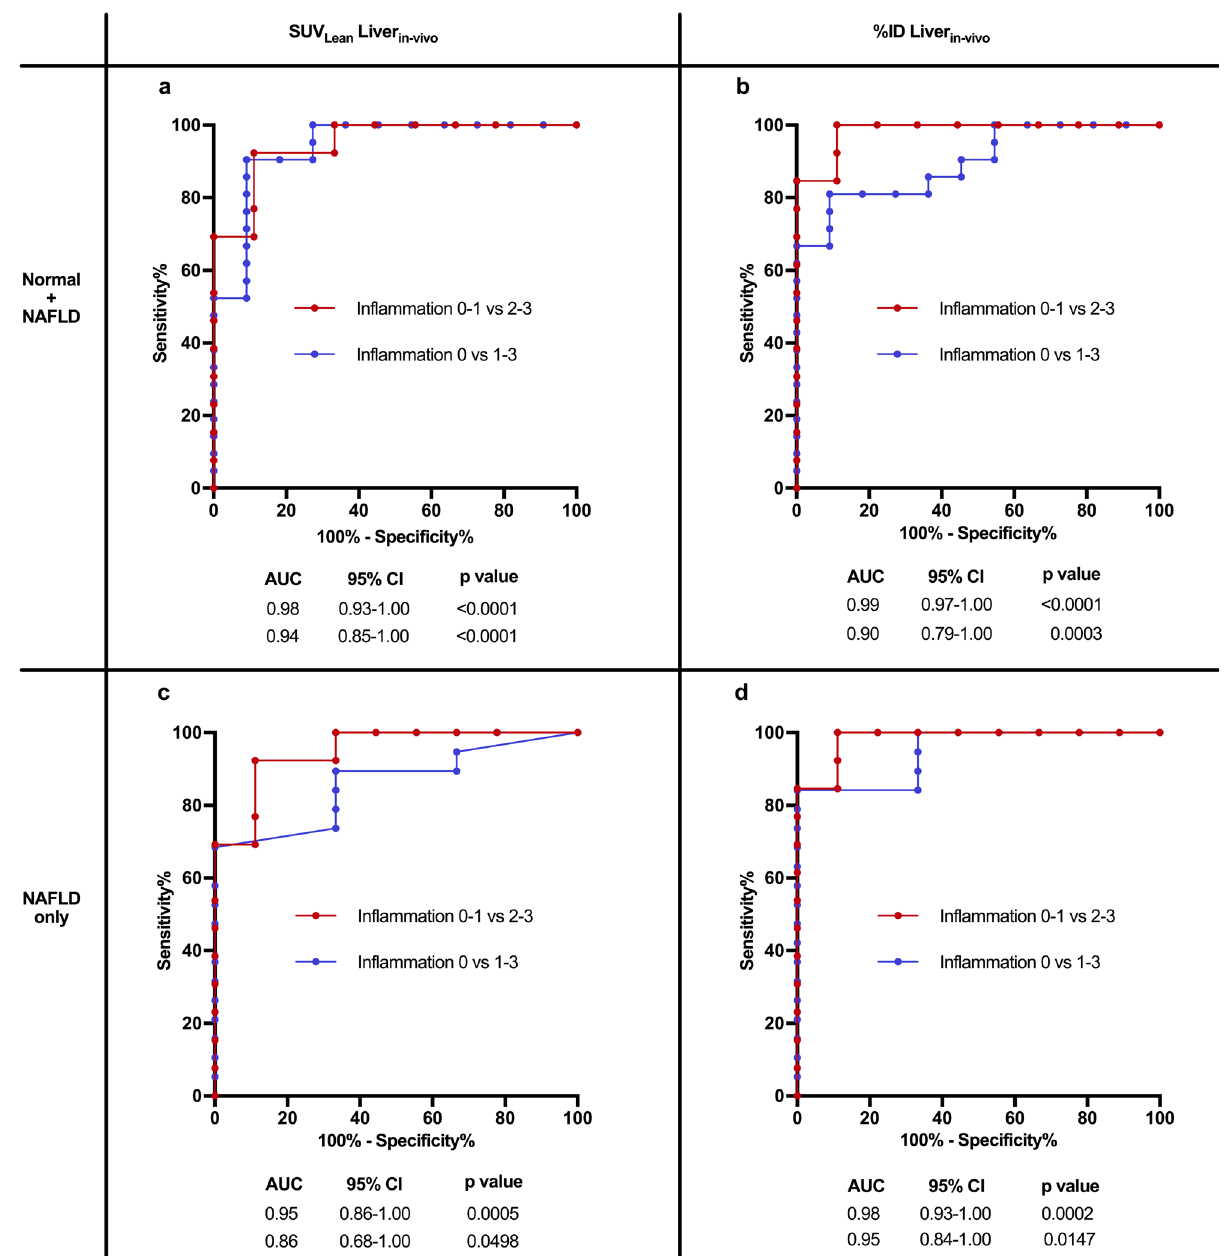
Fig. 6 | 99m Tc-cAbVCAM1-5 uptake robustly re fl ects on liver in fl ammation in a fatty liver. ROC curves for detection of liver in fl ammation a in the entire cohort (Normal+ NAFLD)usingSUV Lean Liver in-vivo values,or b using%ID Liver in-vivo values, and c only in animals with liver steatosis (NAFLD only) using SUV Lean Liver in-vivo